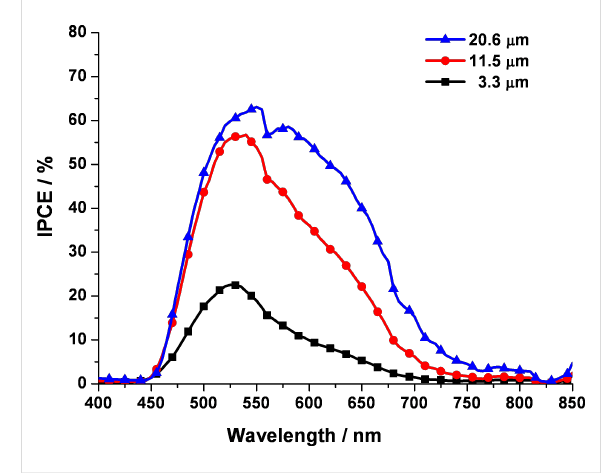
Figure 3: IPCE spectrum of the N719-DSSCs fabricated by using 3.3 μ m, 11.5 μ m, and 20.6 μ m TNT arrays.